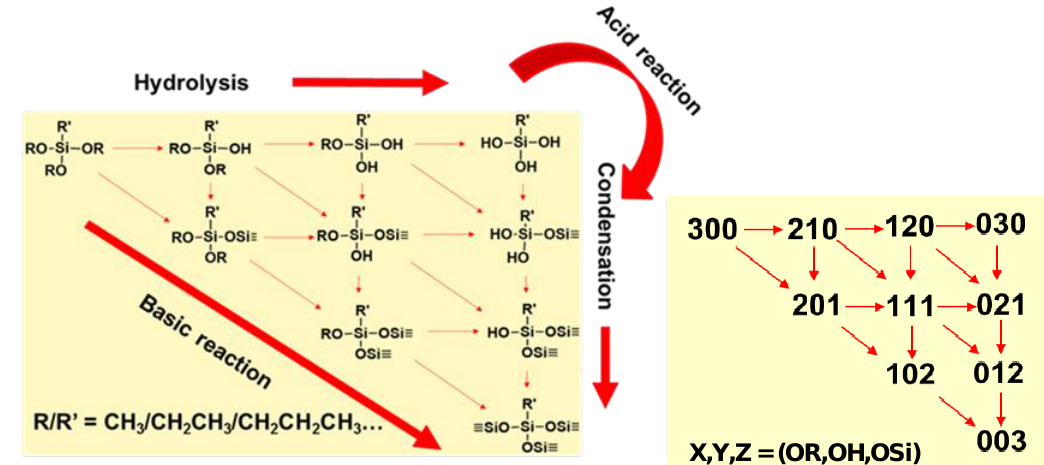
Figure 1. Schematic of the reaction scheme of hydrolysis and condensation kinetics of tri-alkoxysilanes under acidic and basic conditions in aqueous media, along with a numerical reaction scheme [11]. Here, (300), (030), and (003) represent the -OR, -OH, and -OSi functionalities, respectively, around a single Si atom. The neat silane consists of three alkoxy groups (300), which under acidic conditions are sequentially hydrolyzed to three hydroxyl groups (030), which may subsequently condense to produce three siloxane bonds around the Si center (003).